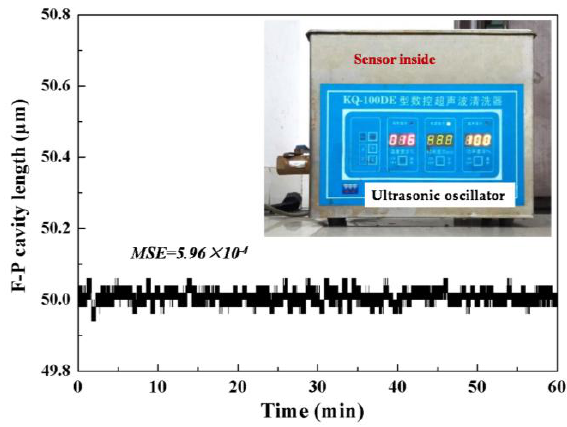
Figure 8. Experimental results of the demodulated F-P cavity values when F-P sensor is in vibration environment.